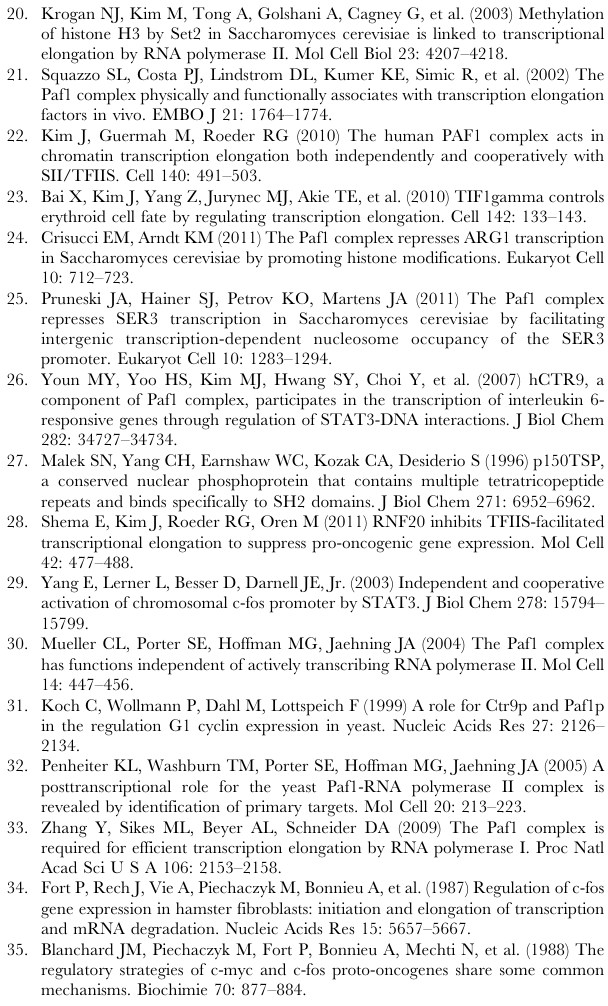
Figure S2 Top, diagram of the Hp genomic loci. PCR primers used for ChIP analyses are shown as two-sided arrows. HepG2 cells were treated with IL-6 plus IL-6sR (20 ng/ml each) for the indicated length of time. Soluble chromatins were immunoprecipitated with anti-CTR9 antibodies, and the bound DNAs were analyzed by quantitative PCR using primers specific to Hp loci. Error bars represents SD (n= 3). Table S1 Primer sequences used for PCR